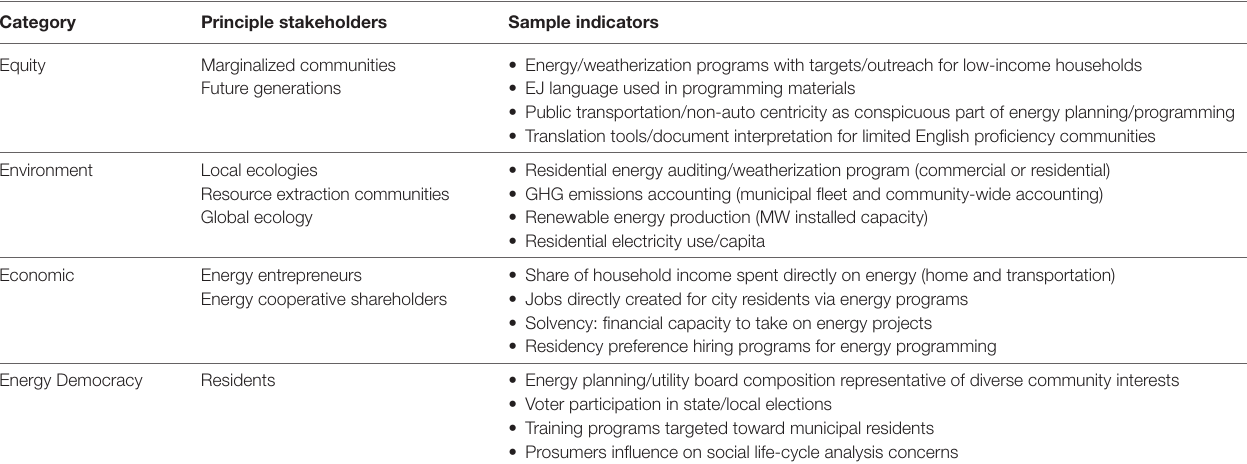
table 1 | Suggested energy democracy indicators for municipal energy regimes including equity, environmental, and economic categories.